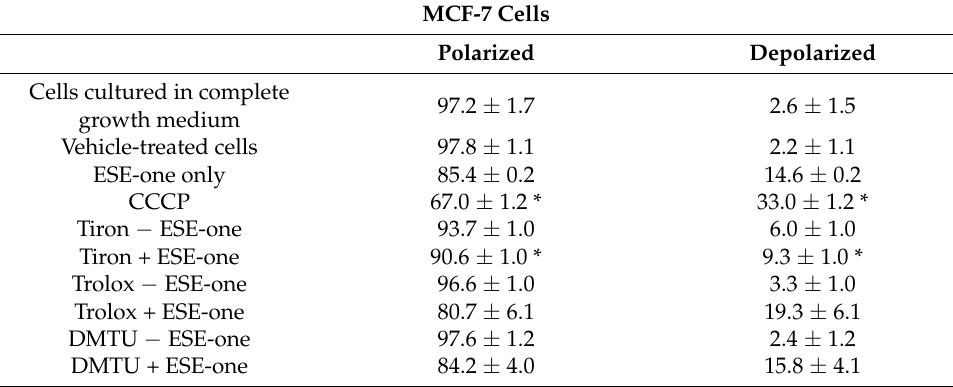
Figure 4. Mitochondrial membrane graphs of MCF-7 cells treated with ESE-one in the presence or absence of several scavengers of reactive oxygen species (tiron, trolox and DMTU). ESE-one only exposure resulted in depolarization of the mitochondrial membrane potential in MCF-7 cells and tiron countered that effect significantly. A represents polarized cells and B represents depolarized cells. Trolox and DMTU did not have an opposing effect on the membrane depolarization exerted by ESE-one (A indicates polarized population and B indicates depolarized population). ( a ) Cells cultured in complete growth medium, ( b ) vehicle-treated cells, ( c ) cells exposed to ESE-one, ( d ) cells exposed to carbonyl cyanide 3-chlorophenylhydrazone (CCCP), ( e ) cells exposed to tiron only, ( f ) cells coexposed to tiron and ESE-one, ( g ) cells exposed to trolox only, ( h ) cells coexposed to trolox and ESE-one, ( i ) cells exposed to DMTU only, ( j ) cells coexposed to DMTU and ESE-one. Table 5. Percentage of MCF-7 cell polarity of the mitochondrial membrane potential as determined by means of flow cytometry. An asterisk (*) indicates p -value ( p < 0.05) compared to ESE-one treated